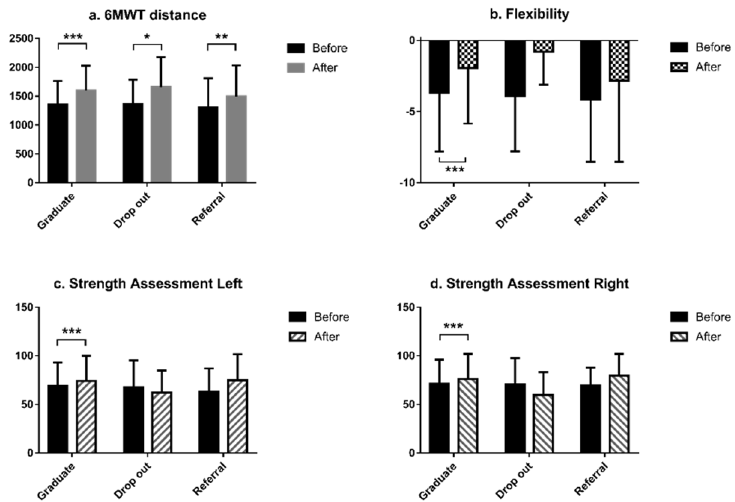
Figure 1. Physical assessment before and after cardiac rehabilitation in the three patient groups (Graduate, Dropout, and Referral). ( a ) Six-minute walk test (6MWT) distance differences in paired t -tests; ( b ) flexibility differences in paired t -tests; ( c ) strength assessment of left arm differences in paired t -tests; and ( d ) strength assessment of right arm differences in paired t -tests. * p < 0.05, ** p < 0.01, and *** p < 0.001.